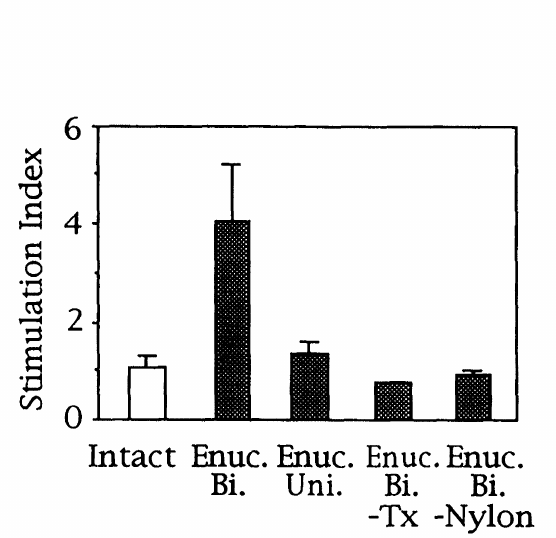
FIGURE 5 Effect of unilateral enucleation, thymectomy, and removal of APCs on proliferative responses. Splenocytes were pre- pared from intact adult frogs (Intact), from those bilaterally enucle- ated at stage 43 (Enuc.Bi.), unilaterally enucleated at stage 43 (Enuc.Uni.), or from those bilaterally enucleated at stage 43 and thymectomized at stages 45 to 47 (Enuc.Bi.-Tx). Some splenocytes obtained from frogs bilaterally enucleated at stage 43 were passed through nylon wool columns (Enuc.Bi.-Nylon) as described in Materials and Methods. The number of BrdU-incorporated prolifer- ating splenocytes is shown as the relative proliferating rate (Stimu- lation Index) on the 5 th day of culture. The actual proliferating cells in the control culture was 3.60%, where the stimulation index was 1. Values represent means SD obtained from three replicate cul- tures, except for those of splenocytes from frogs enucleated at stage 43 and thymectomized at stages 45 to 47 which were obtained from two replicate